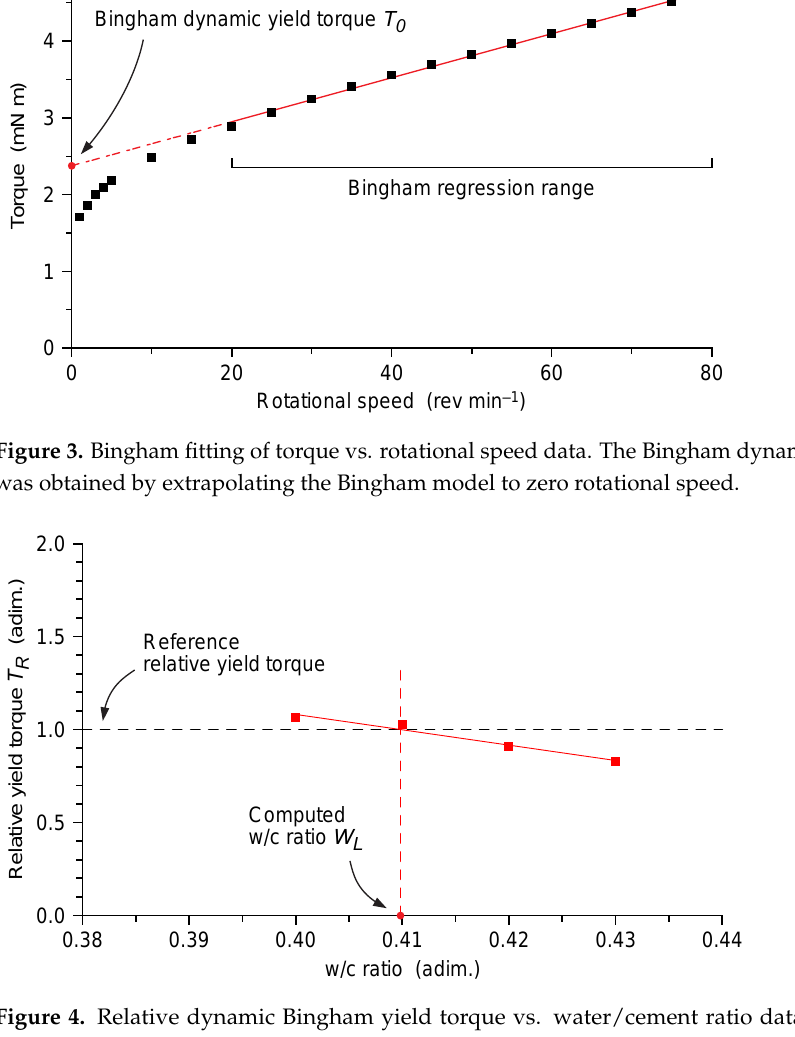
Figure 4. Relative dynamic Bingham yield torque vs. water/cement ratio data set for the BSG T Lignin cement paste sample and determination of computed w/c ratio W L . The Bingham yield torque measured at each w/c ratio (red squares) was relative to the yield torque of the reference cement paste (without lignin) at 0.45 w/c ratio. The W L value obtained with the lignin containing cement paste was calculated intersecting the reference yield torque value (black dotted line) with the sample points data fitting line (red solid line).